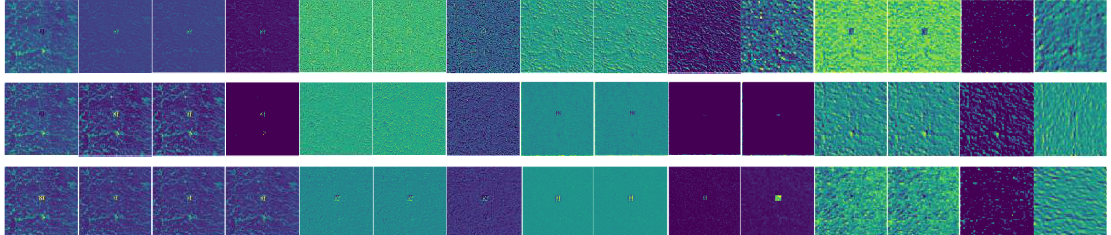
( d ) Figure 7. The four cut mineral microscopic images : ( a ) Kf ; ( b ) Pe; ( c ) Pl; ( d ) Qz. Table 2. The numbers of sample data of rock-mineral microscopic images. Mineral Number of Images in Each Class Total Number of Images Kf 116 - 481 - - Pe 122 Pl 122 Qz 121 4. Model Establishment and Evaluation In the process of OPS microscopic rock-mineral image feature extraction using Inception-v3, there is no special limitation to the raw data. The size of the images can be processed to be 299 × 299 × 3 automatically before training, where 299 denotes the height and width of the image size, and 3